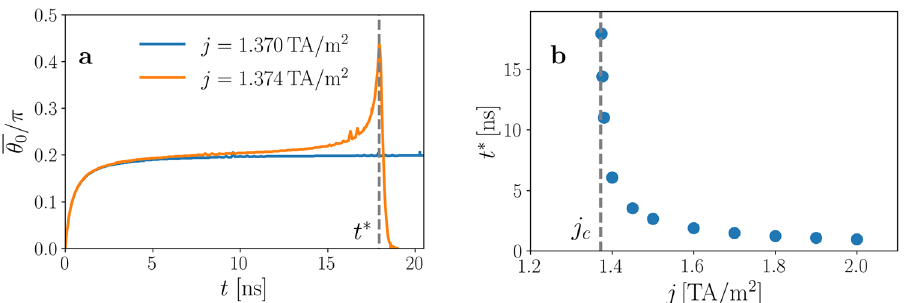
Figure 4. Instability of the chiral soliton under an applied current density. ( a ) Evolution with time of the tilt angle ¯ θ 0 around the critical current j c . The vertical line indicates the value of t ∗ for j = 1.374 TA/m beyond which the magnetization in the center of the soliton abruptly goes to the y direction. ( b ) Dependence on the current density of the instability time t ∗ ( j ) , showing how it seems to diverge when approaching j c = 1.372 TA/m 2 from